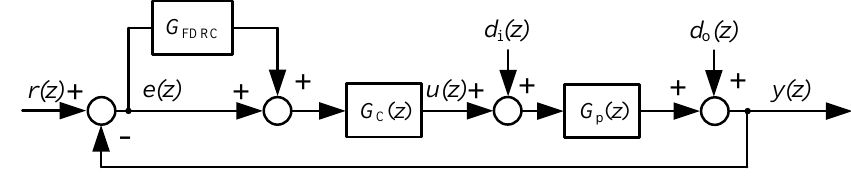
Figure 4. Scheme of the plug-in repetitive control system with